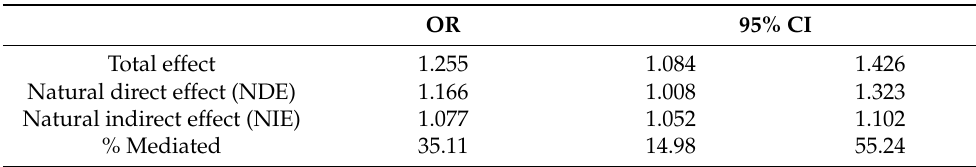
Table 2. The mediation analysis of hyperuricemia’s effect on the association between the FMR and reduced eGFR among men aged